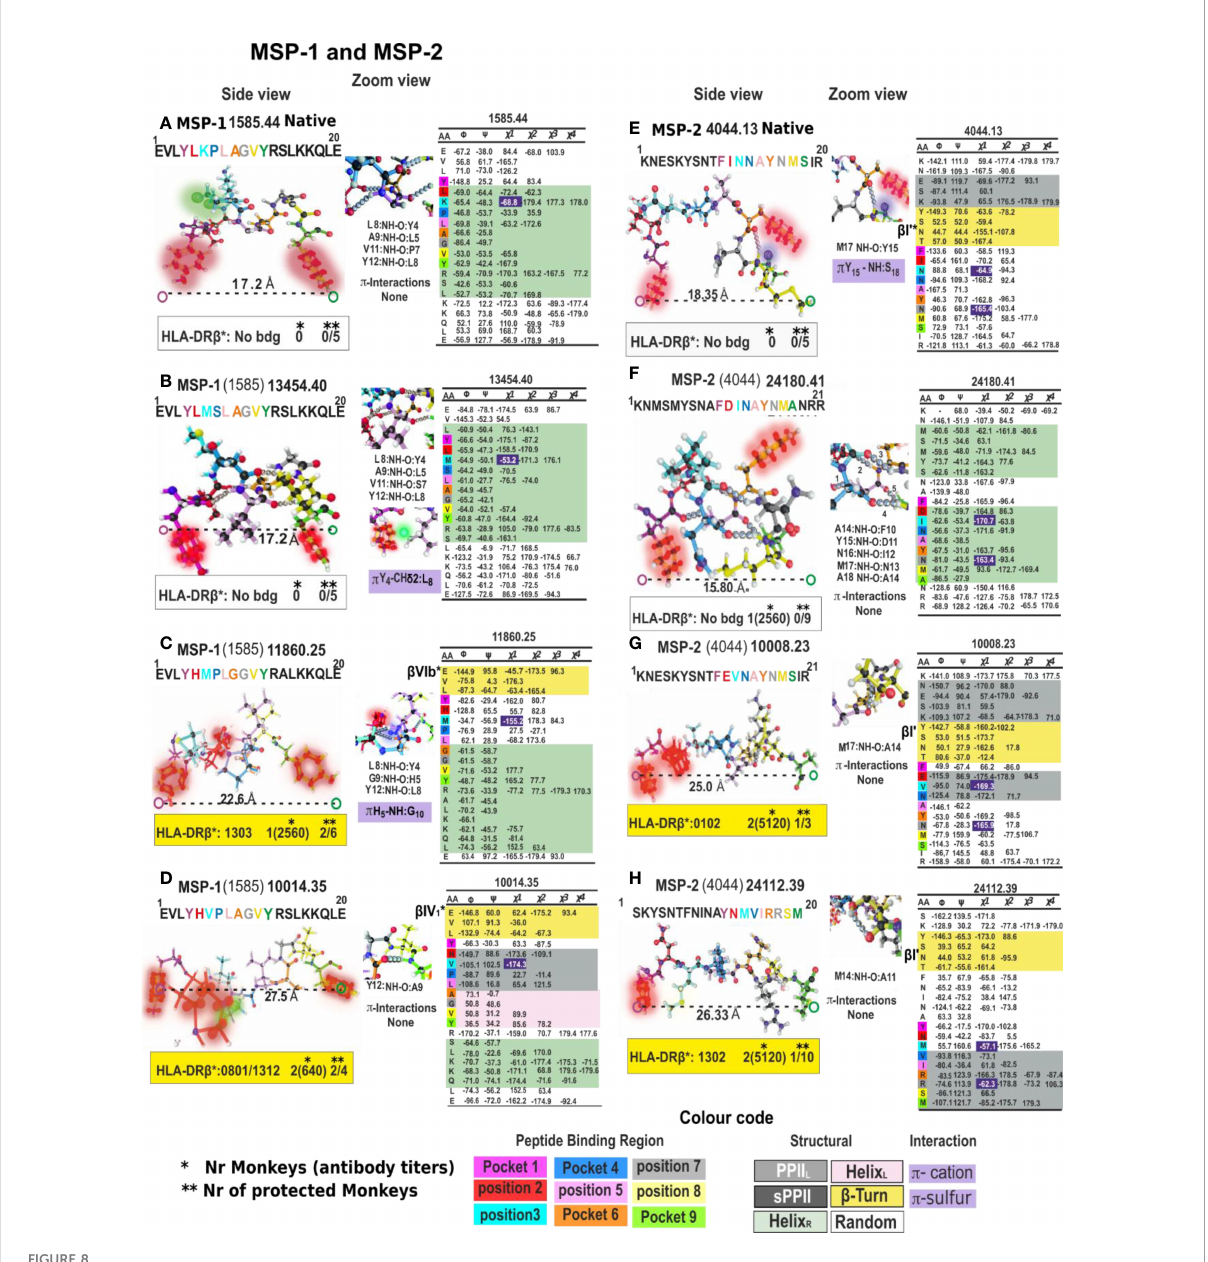
FIGURE 8 Right-hand panel: Dihedral angles table showing powerful 1H-NMR cHABPs and mHABPs conformers angle determinations, with representative torsion angles ( f , y , c 1, c 2, c 3 and c 4) in native; non-immunogenic, non-protection-inducing; immunogenic, non-protection-inducing mHABPs and immunogenic, protection-inducing mHABPs or IMPIPS. In dihedral angles table, PPIIL region (grey), sPPII region (dark grey), b -turns (yellow), right-handed alpha helix ( a R green), left-handed alpha helix ( a L (pink) and random coil structure (uncoloured). c 1 angles for P3 and P7 highlighting gauche+ rotamer orientation (purple) (22). Left-hand panel: Side view of cHABP and mHABP structures (1H-NMR) in the binding region to HLA-DR b 1*: aa sequence above (binding residues coloured according to colour code shown below: Pocket 1 (fuchsia), Pocket 4 (dark blue), Pocket 6 (orange), Pocket 9 (green), position 2 (red), position 3 (light blue), position 5 (pink), position 7 (grey), position 8 (yellow)). Distances between the most distant residues fi tting into HLA-DR b 1*PBR Pockets 1-9 (dotted lines are measurements in Angstroms (Å)). Boxed IFA titres and the amount of monkeys protected after challenge (yellow). (*) Nr Monkeys (antibody titers) and (**) Nr of protected Monkeys. Zoom shows intramolecular H-bonds and p interactions (31) between the atoms described below (dotted light grey balls). For this fi gure, MSP- 1- and MSP-2-derived cHABPs and